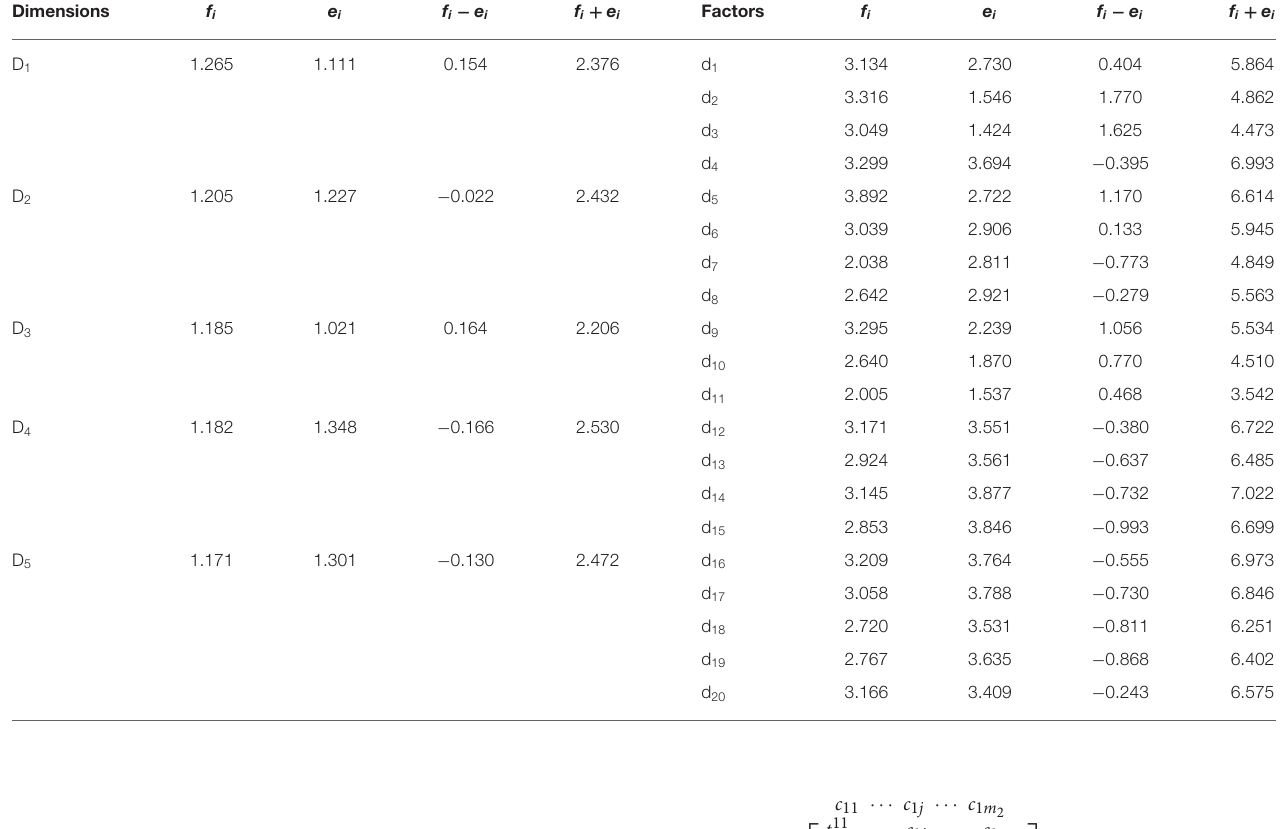
TABLE 4 | Results of DEMATEL.